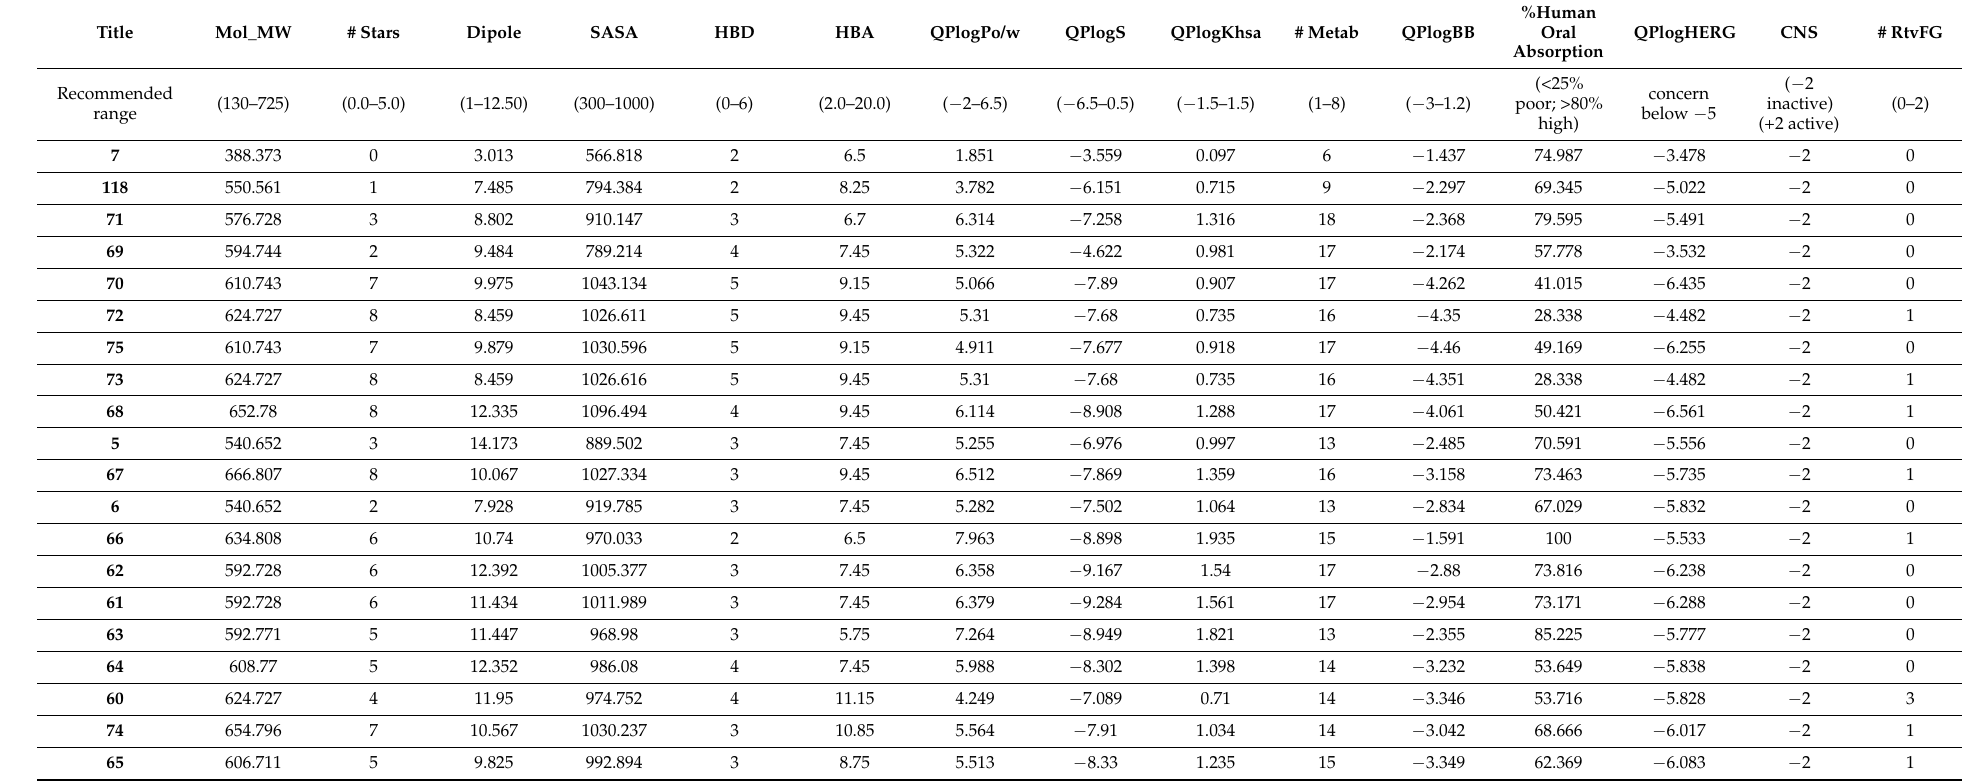
Table 4. Predicted in silico ADME properties of the phenalenone